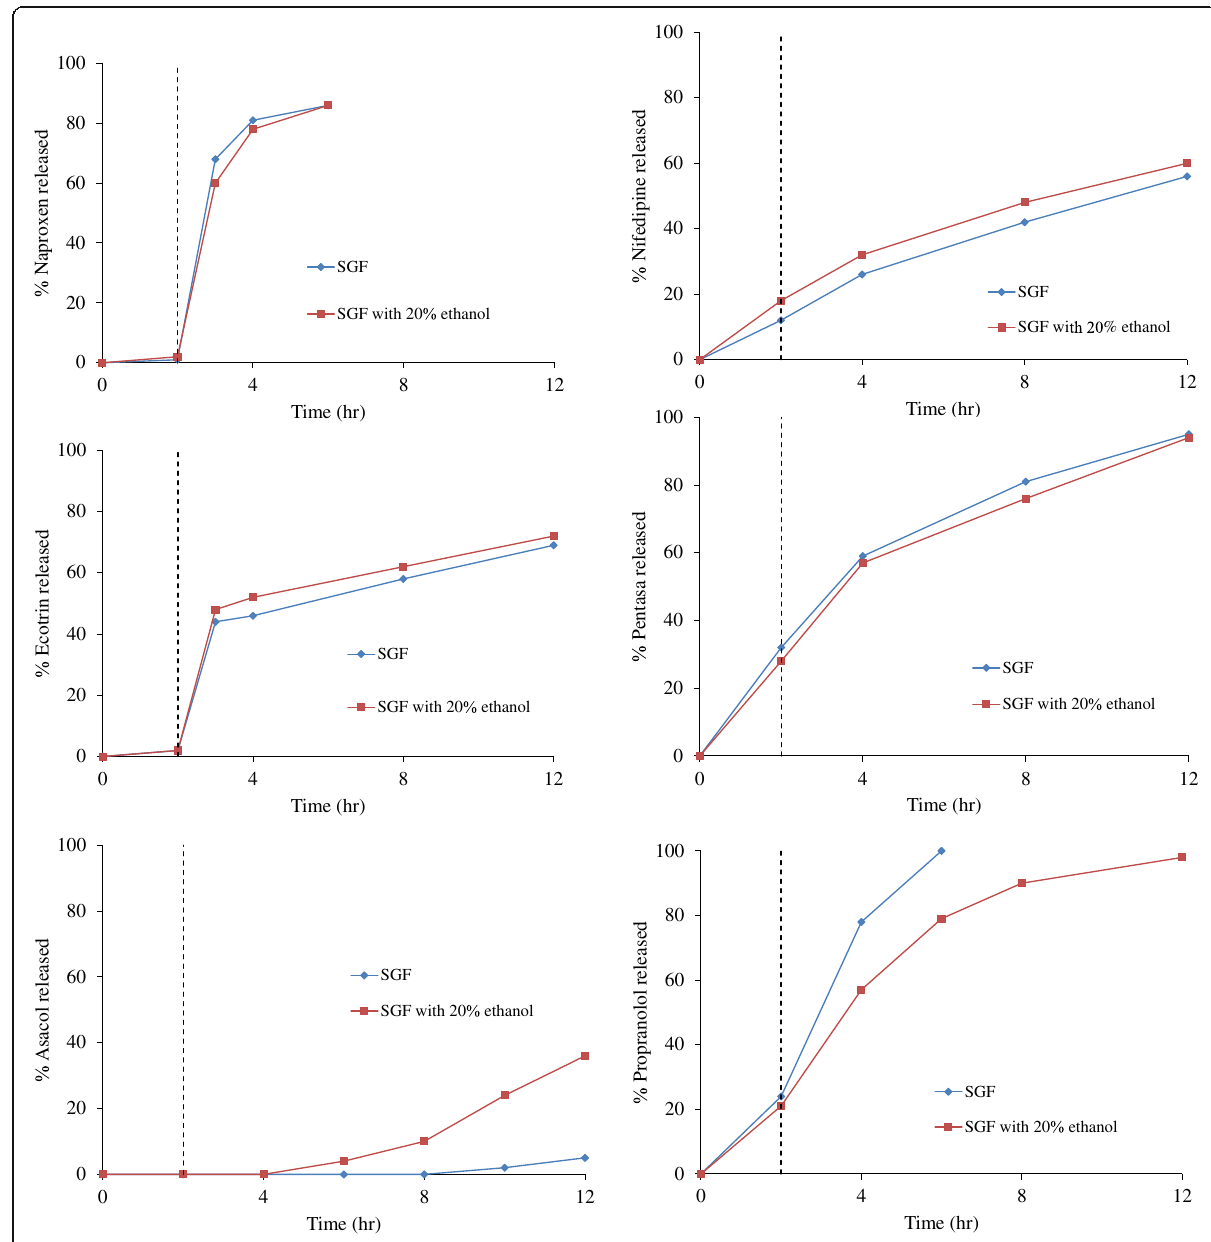
Fig. 31 Effect of alcohol on release Naproxen EC, Ecotrin®, and Asacol® tablets (delayed release), and prolonged release dosage forms, namely, Nifedipine ER tablets, Propranolol ER, venlafaxine XR, and Pentasa® capsules (dotted line indicates a change from SGF with or without ethanol, to SIF) (data from reference (Talukder et al.